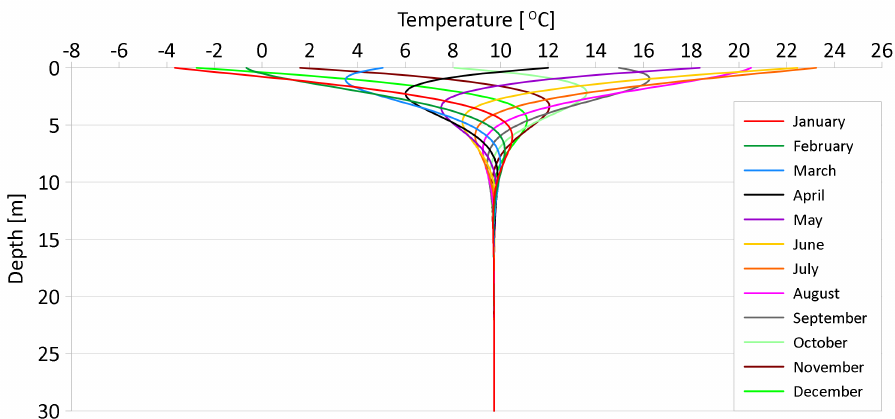
Figure 2. Natural ground temperature profiles for individual months of the year; k = 1.4 W/ ( mK ) . The profiles of the temperature in the ground, from which the heat is extracted with a maximum heat flux of 15 W/m 2 are shown in Figure 3. The graph shows the deformation of the profile toward lower temperatures compared to the profiles for the natural conditions (Figure 2). The temperature is fixed at the depth of about 25 m, i.e., well below the value for natural conditions. A significant reduction in the temperature of the ground in comparison with the natural conditions is due to heat extraction from the ground in the heat exchanger, uncompensated entirely by the heat transfer from the